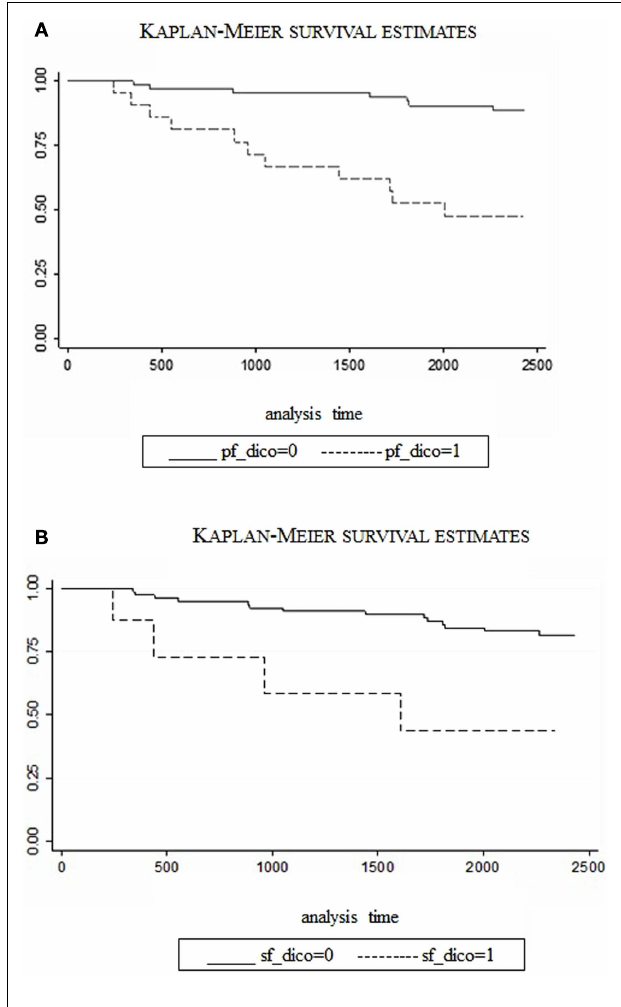
Table 5 | Characteristics of survival and deceased patients .